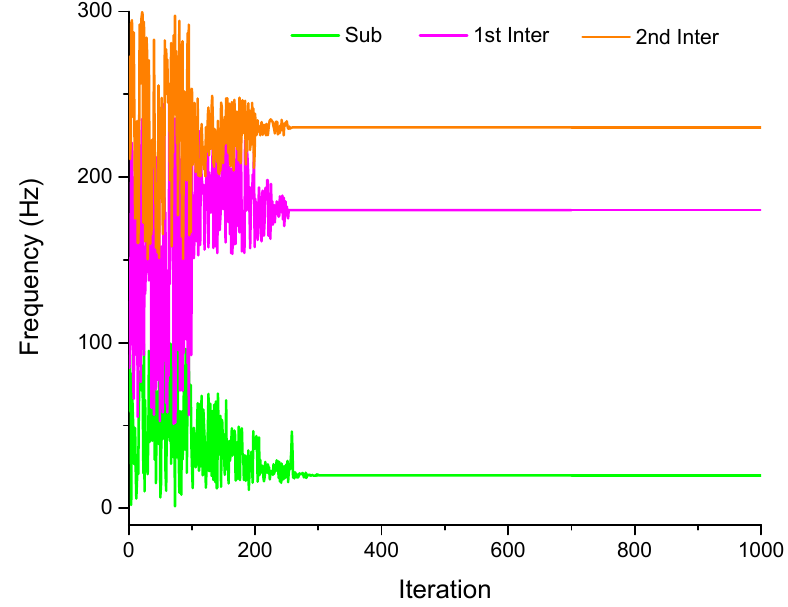
Figure 17. Frequency estimation for case study II.